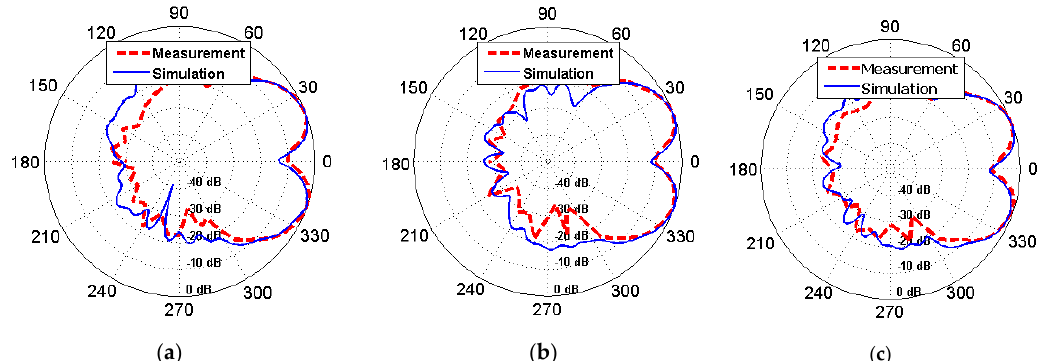
Figure 12. Comparison between measured and simulated far-field radiation pattern of H-plane SIW antenna array with two-way 180-degree out-of-phase power divider at ( a ) 26.5 GHz ( b ) 27 GHz, and ( c ) 27.5 GHz .